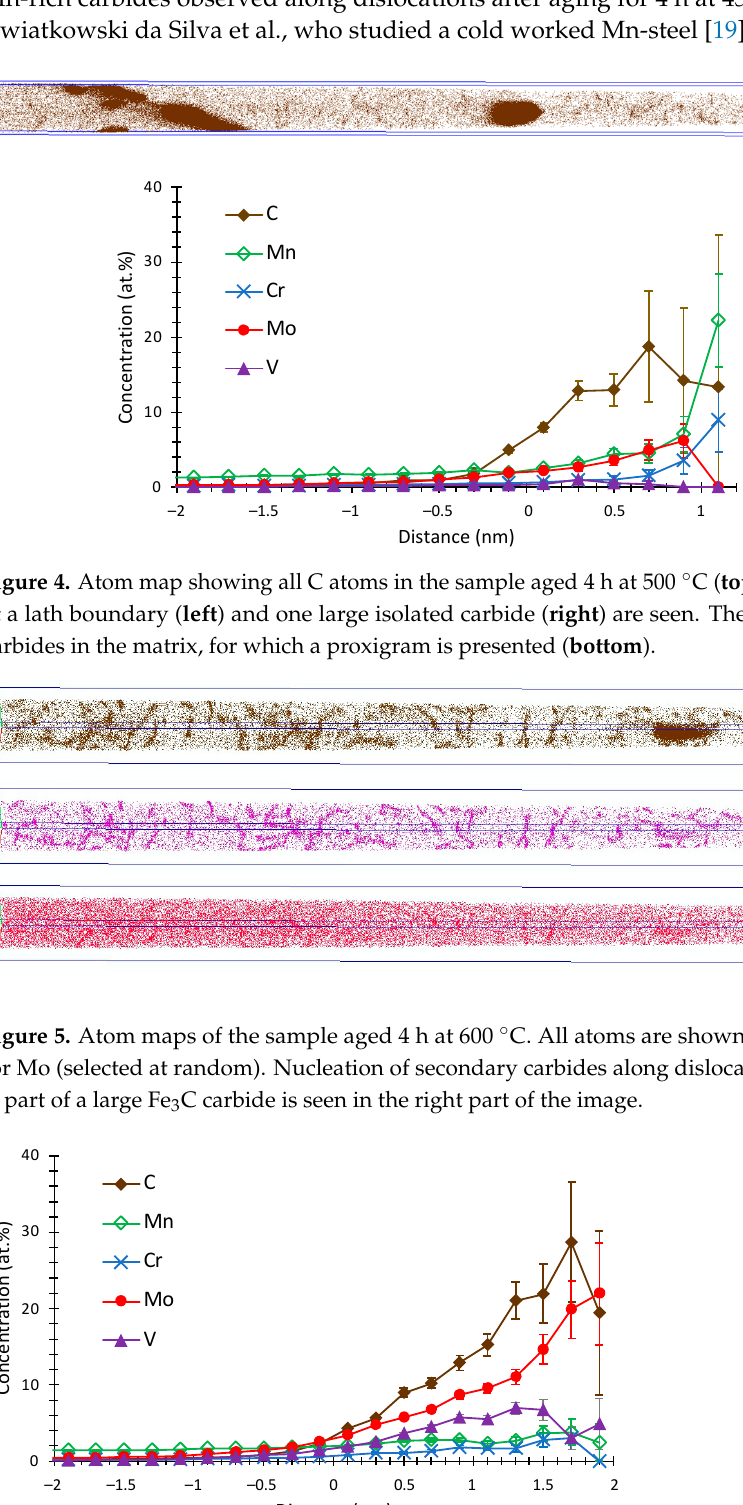
Figure 4. Atom map showing all C atoms in the sample aged 4 h at 500 °C ( top ). Cementite carbides at a lath boundary ( left ) and one large isolated carbide ( right ) are seen. There are also very small carbides in the matrix, for which a proxigram is presented ( bottom ).